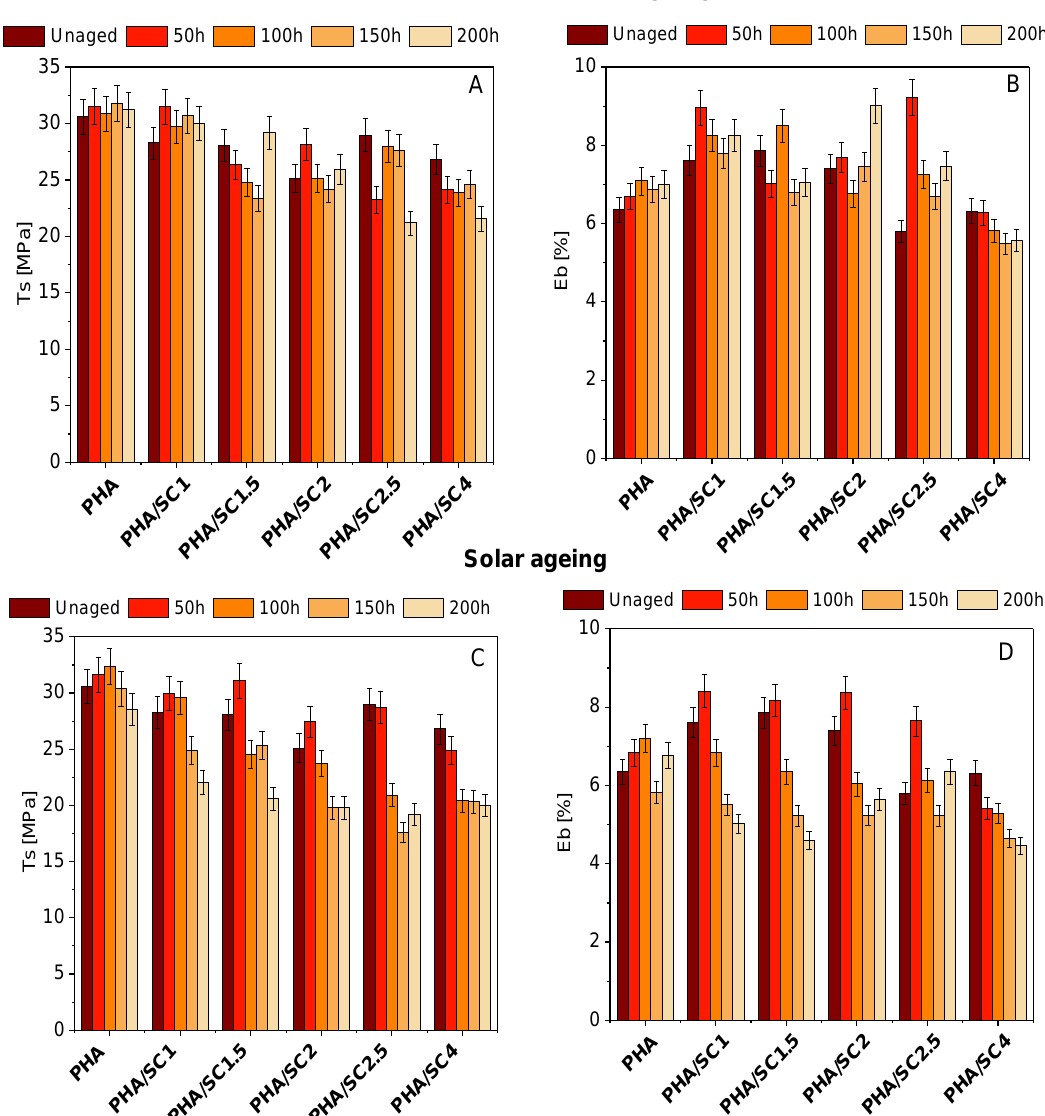
Figure 6. The changes in PHA mechanical properties (Ts, the tensile strength, and E b , the elongation at break) before and after thermooxidation ( A , B ) and solar aging ( C , D ).